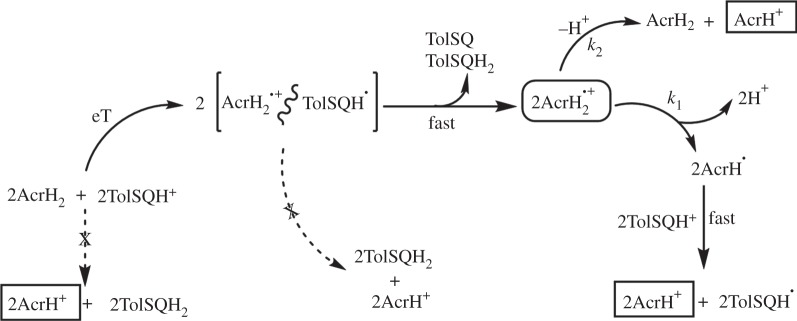
Mechanism of reduction of TolSQH+ by AcrH2 (adapted from Yuasa et al. [38]). eT, electron transfer.